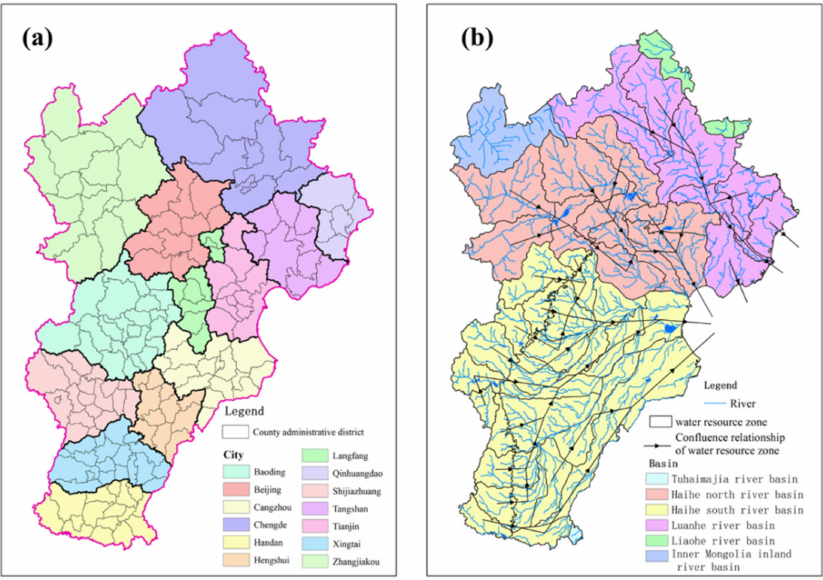
Figure 7. ( a ) Administrative district and ( b ) water resource zones of study